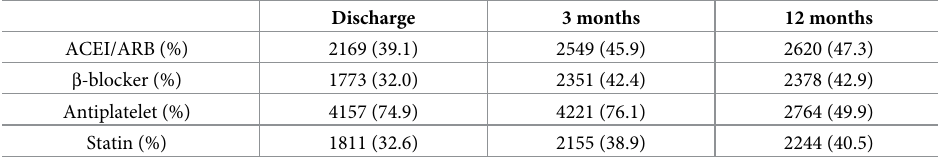
Table 8. Trend in prescription changes over 1 year.